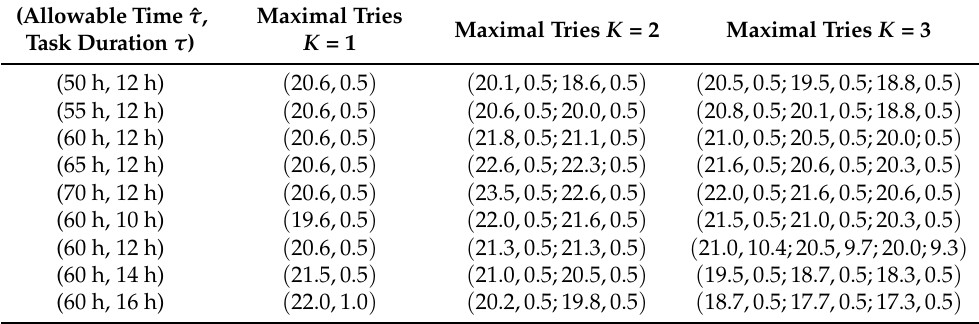
Table 2. Optimal termination and loading policies under MSRII.